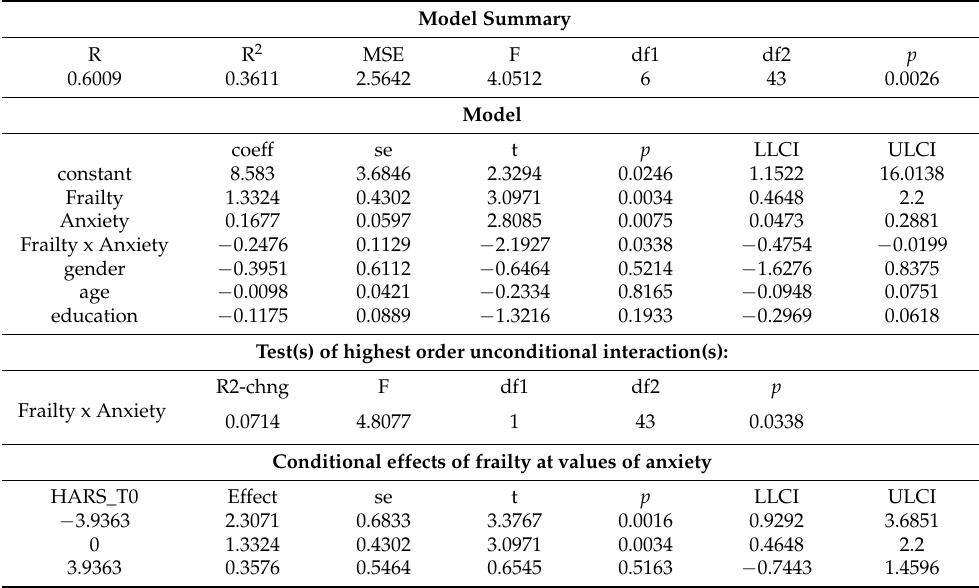
Table 7. Moderation analysis for predicting the perceived threat of SARS-CoV-2 at T2 based on frailty and anxiety, and their interaction, at T0.